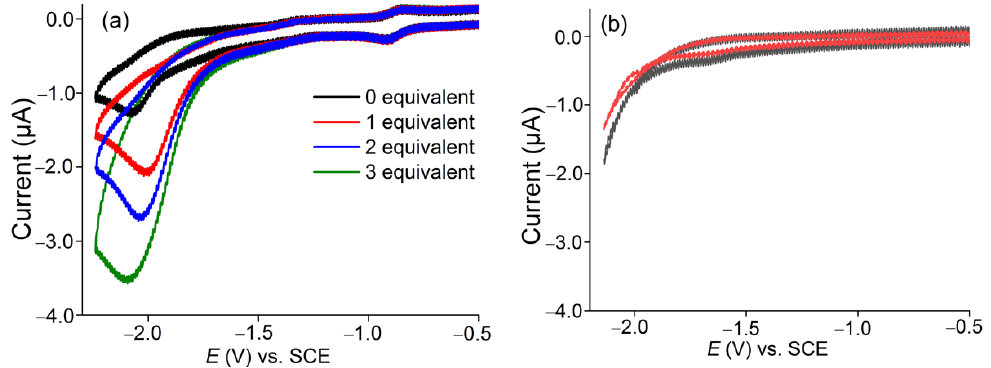
Figure 4. ( a ) CVs of [Co(TTMPP)] (1 mM) in the absence (black trace) or in the presence of 1 to 3 equivalents HNEt 3 BF 4 in DMF at 250 mV s − 1 . ( b ) Blank experiments with no or 1 equivalent of